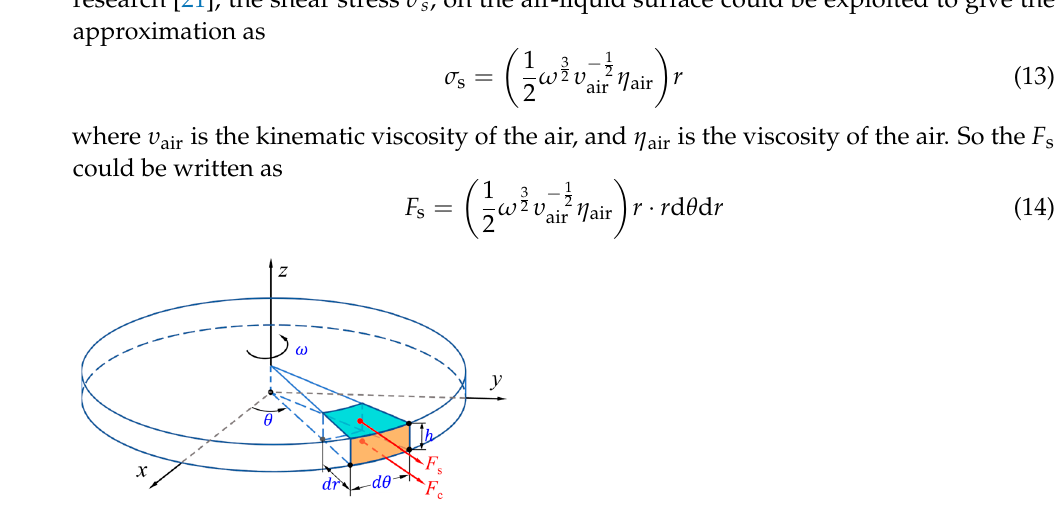
Figure 6. Schematic diagram of liquid film representative elemental volume analysis. It is assumed that the radial velocity of the induced airflow is substantially greater than that of the film layer. Therefore, F s is in the same direction as F c . These two forces acting on the representative elemental volume determined the evolution of film